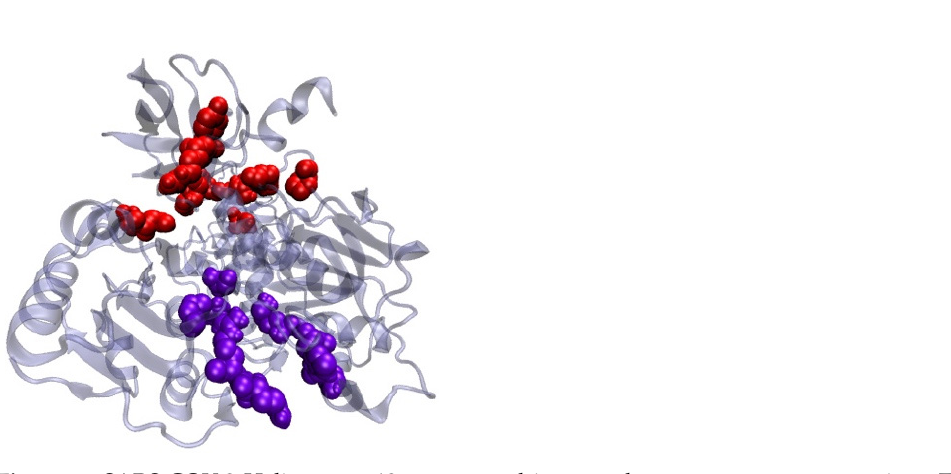
Figure 6. SARS-COV-2 Helicase nsp13 represented in secondary structure representation. The interacting residues for both ss-RNA and ATP binding are in red (Ser485, Lys146, Lys139, Tyr180, His230, Tyr198, Arg212, Pro335, Arg339, Asn516) and violet (Glu537, Arg567, Arg443, His290, Arg442, Asn265, Gly439, Lys288) respectively.